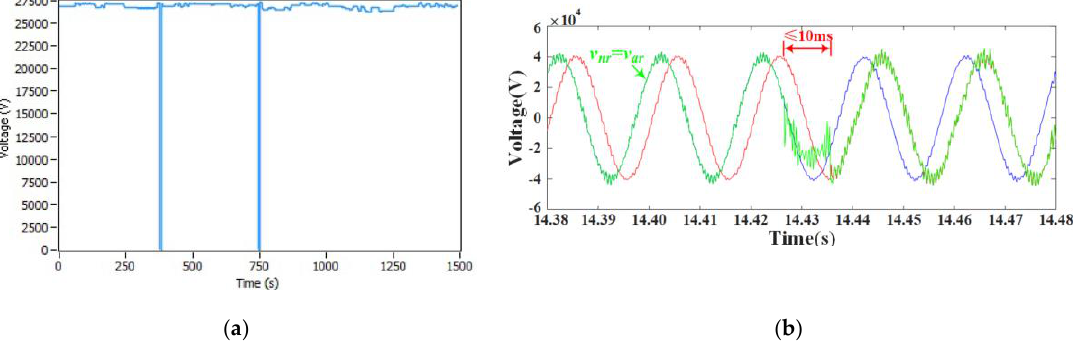
Figure 17. The measured interruption in ERPS. ( a ) Uncontrolled InR in 25 kV AC ERPS line of Italy [112];